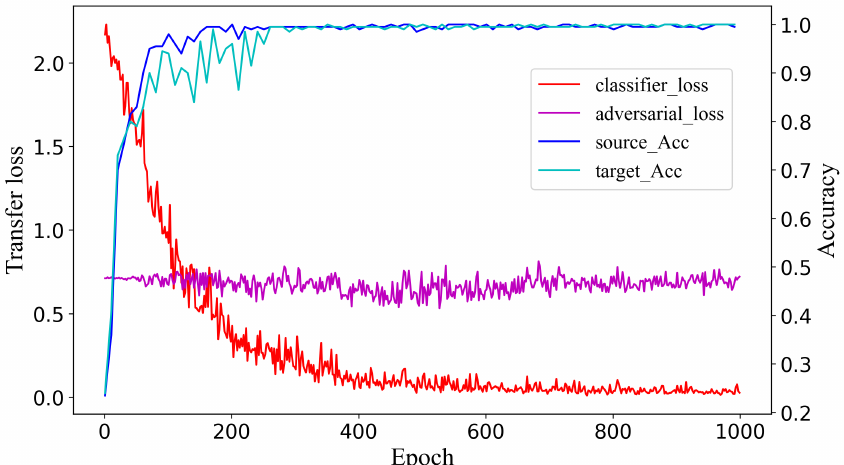
Figure 13. The trend of training accuracy and loss for the proposed method.